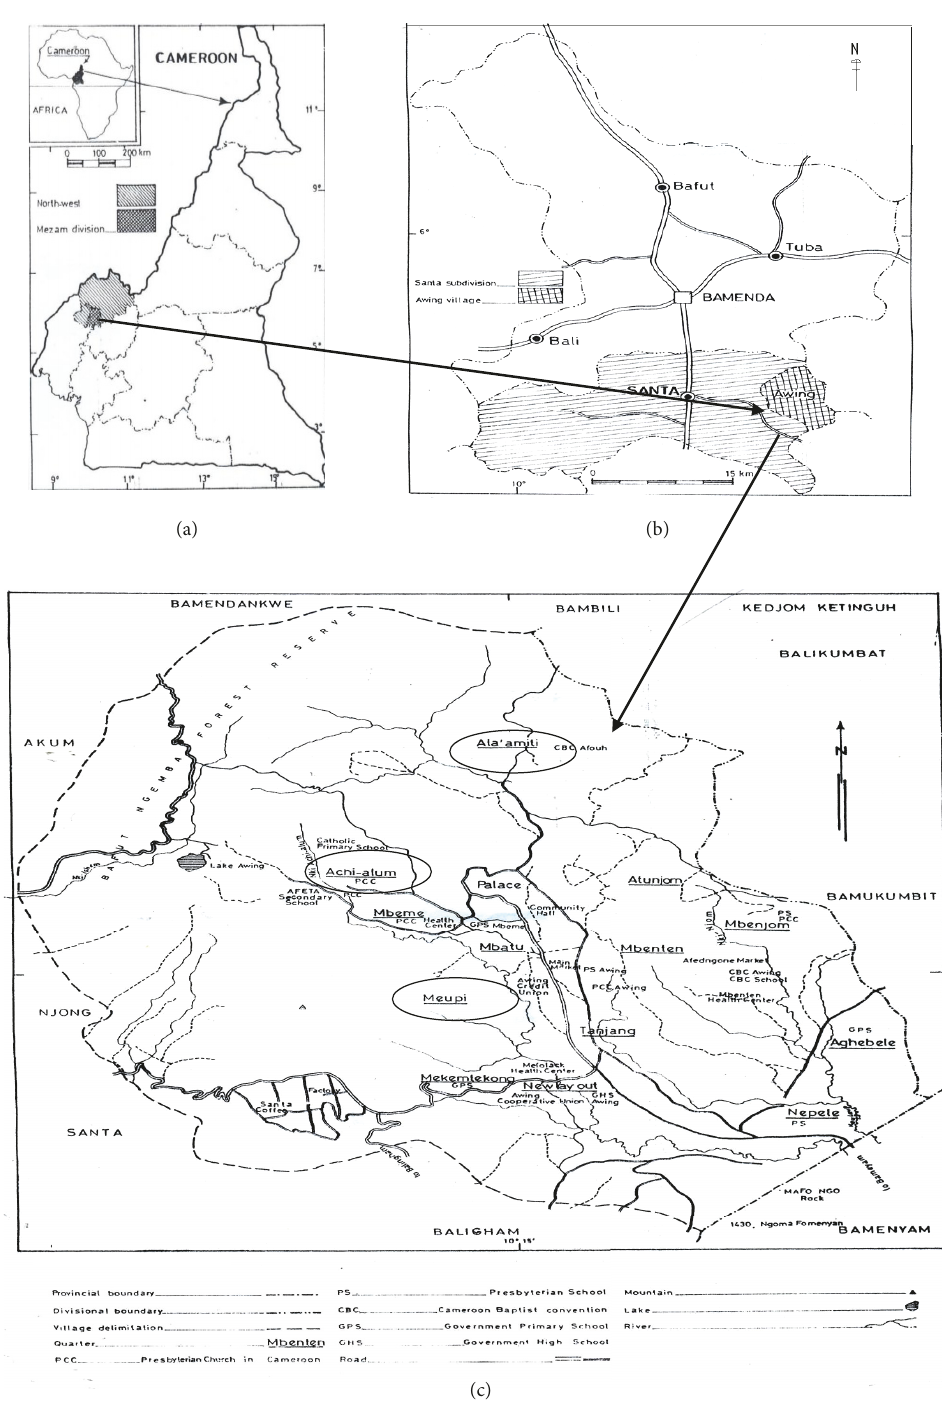
Figure 1: Map of study area. (a) Map of Cameroon showing Northwest and Mezam Division. (b) Map of Mezam Division showing Awing. (c) Map of Awing showing sampling sites (source: